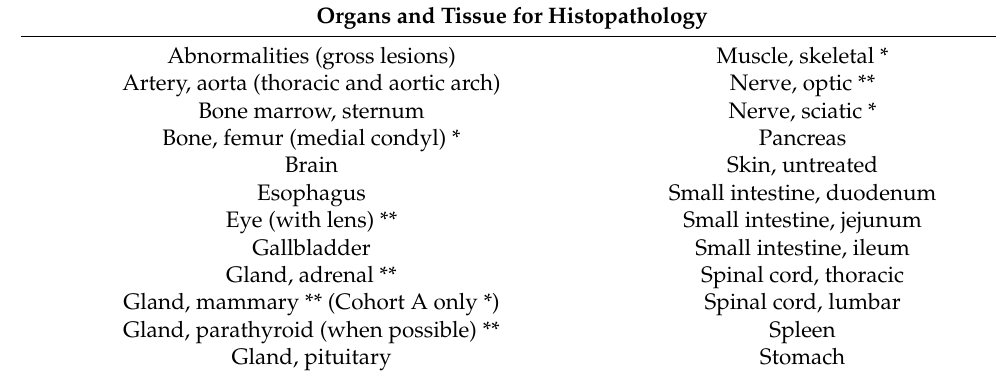
Table A1. Organs and tissues examined by histopathology in cohort A and B. * Indicate unilateral sampling and ** bilateral